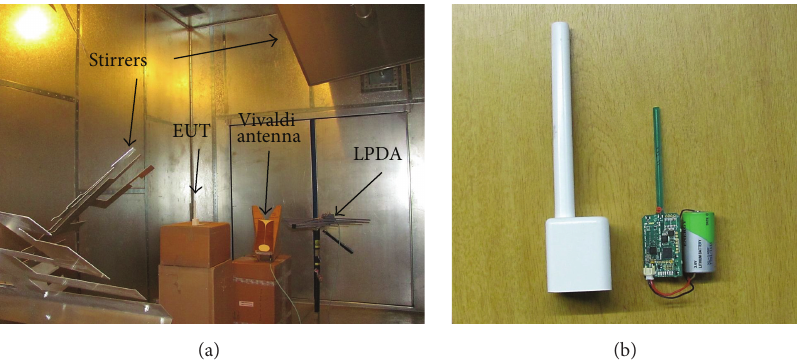
Figure 4: (a) The measurement system in RC; (b) the plastic enclosure and the sensor (EUT).